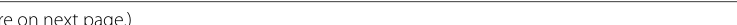
figure on next Fig. 5 Molecular phylogenetic analysis of ruminant papillomavirus based on partial L1 gene nucleotide sequences. Complete L1 sequences were retrieved from GenBank and aligned with MAFFT, and phylogenetic analysis was performed using MEGA X software. The evolutionary history was inferred using the maximum likelihood method and general time reversible model. Numbers at internal nodes represent the bootstrap support values (percentages) determined for 1000 replications. The analysis involved 57 nucleotide sequences, and there were a total of 445 positions in the final dataset. The sequences found in this study are represented in bold. PNT putative new